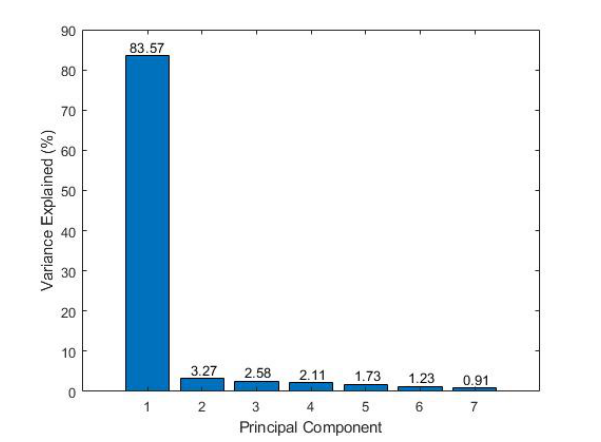
Figure 2. Fractions (%) of Variance Explained by Each of the First 7 Principal